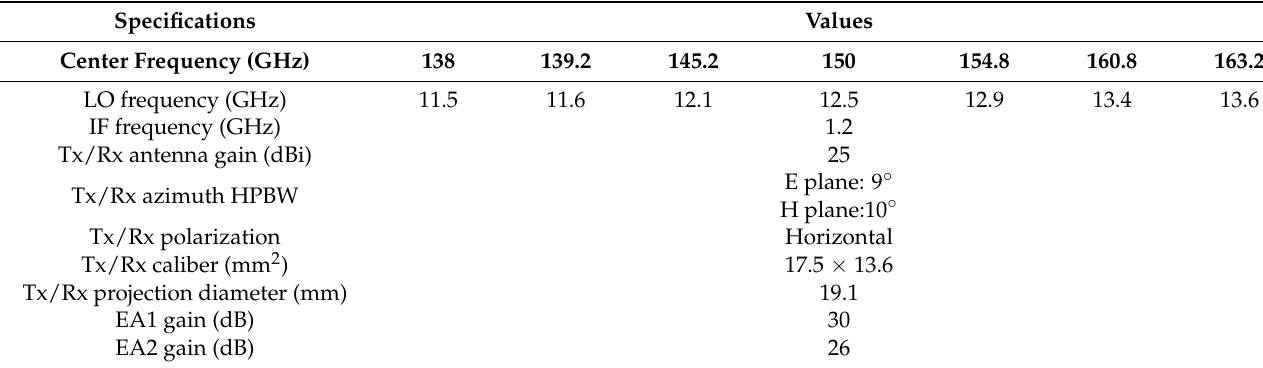
Figure 3. Block diagram of the D-band MMW 800 m transmission experiment system. Table 2. D-band transmission system specifications.